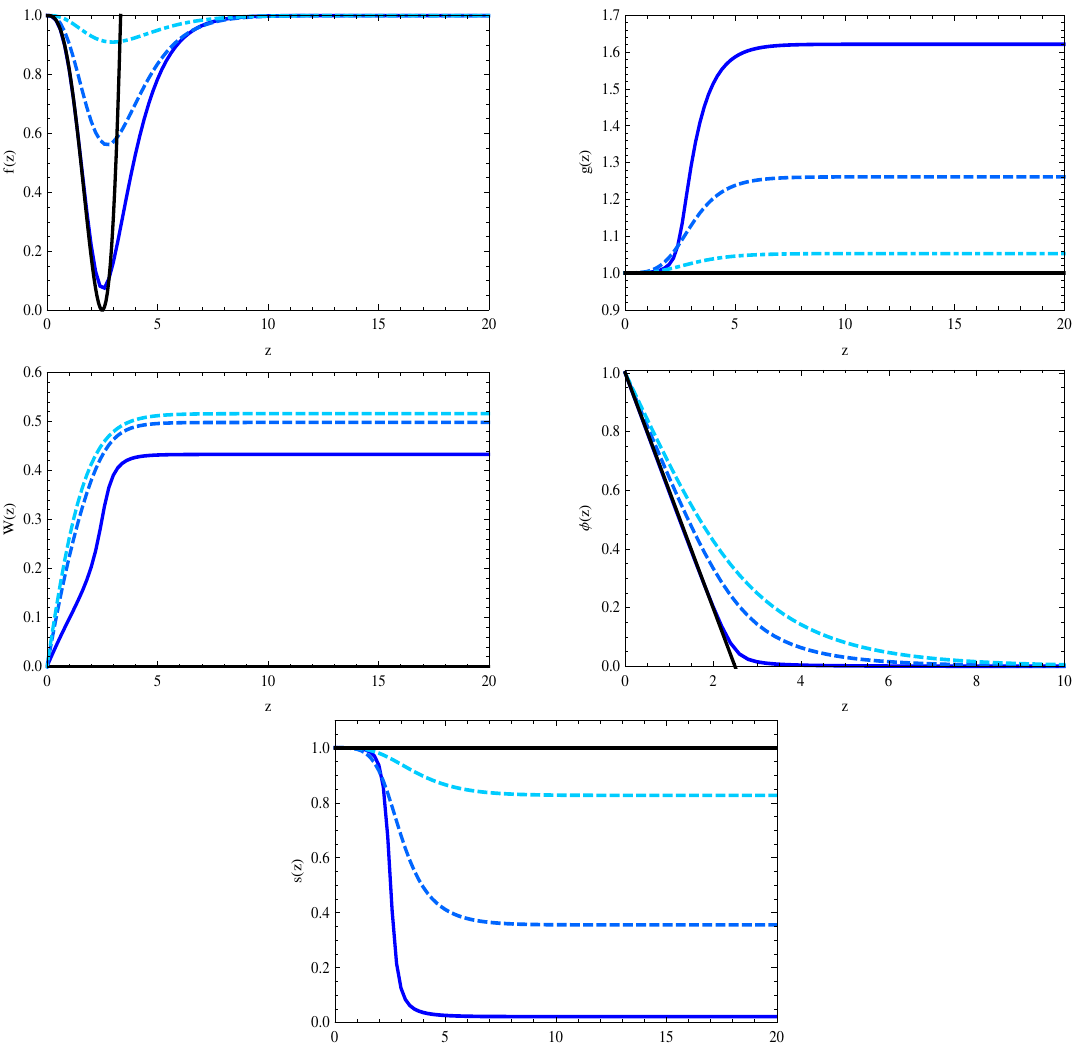
Figure 1. The metric and gauge (cid:12)eld functions at null entropy, for three di(cid:11)erent values of (cid:21) : 0 : 40 (cyan-blue), 0 : 8 (light-blue), 0 : 995 (blue). The black curves correspond to the extremal Reissner-Nordstr(cid:127)om black hole